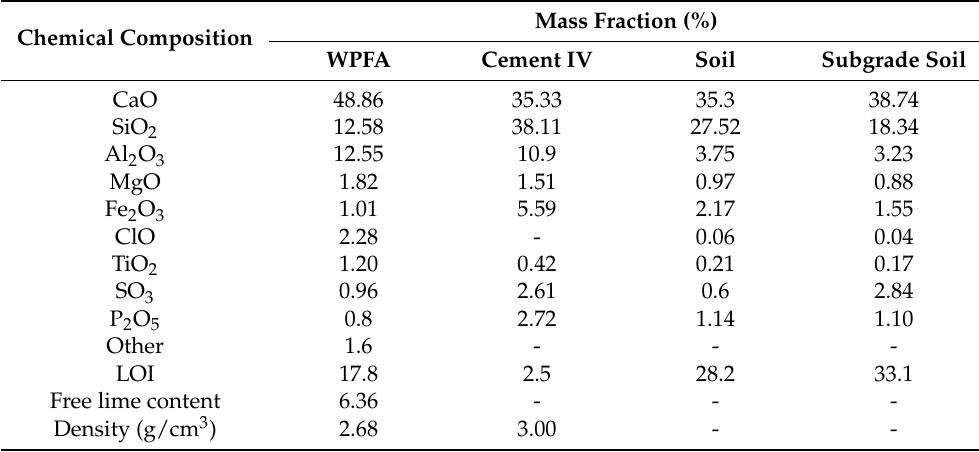
Table 2. Chemical composition of raw materials.